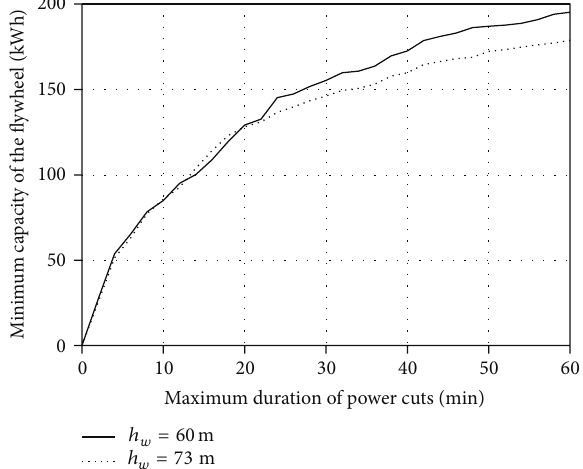
= 𝑓(𝑇 ) for Enercon ESMIN MAX 100kW for the period MIN